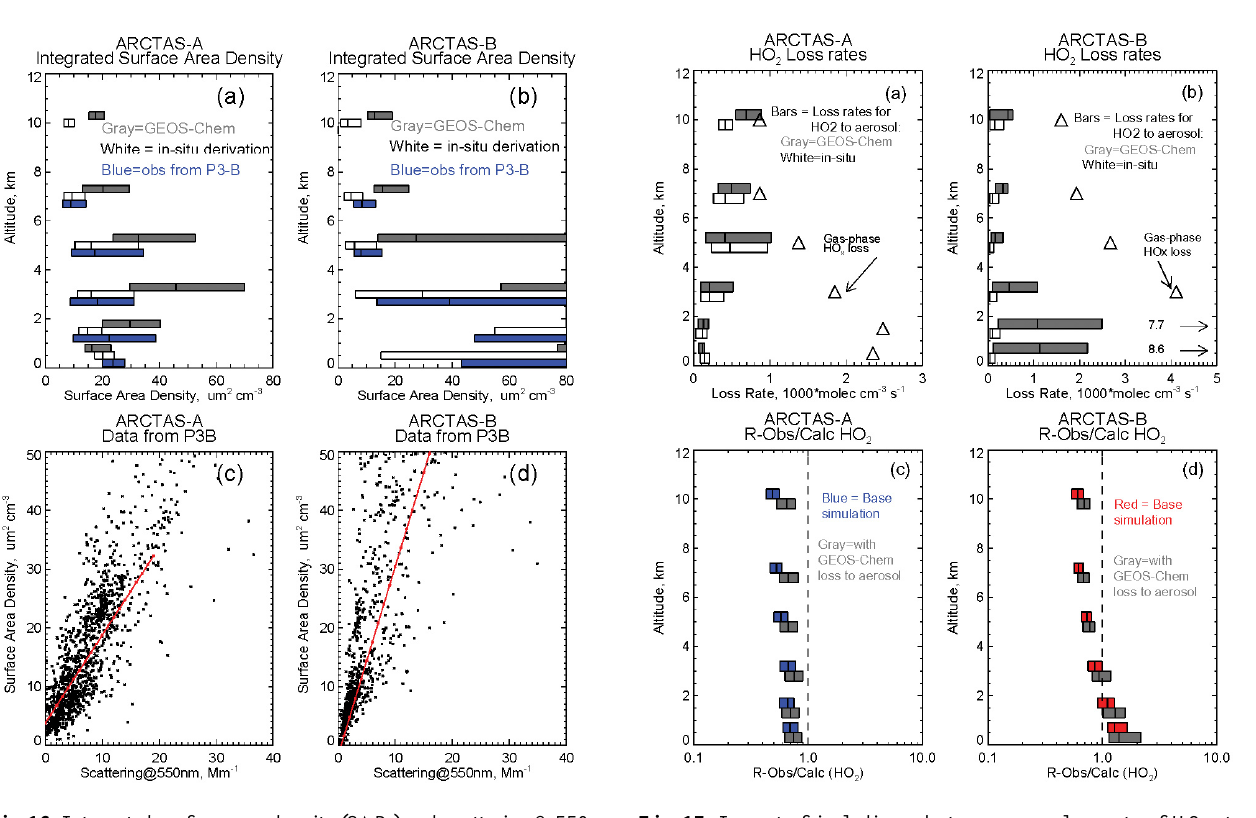
Fig. 17. Impact of including a heterogeneous loss rate of HO 2 to aerosol on predictions of HO 2 . Altitude profiles of the loss rate of HO 2 to aerosol calculated in GEOS-Chem and from using in-situ observations are shown for (a) ARCTAS-A and (b) ARCTAS-B. Predictions of the gas-phase loss of HO 2 using the LaRC box model and in-situ observations are shown for comparison. Altitude profiles of the observed-to-calculated ratios of HO 2 from simulations that do and do not include the heterogeneous loss of HO 2 to aerosol are shown for (c) ARCTAS-A and (d)